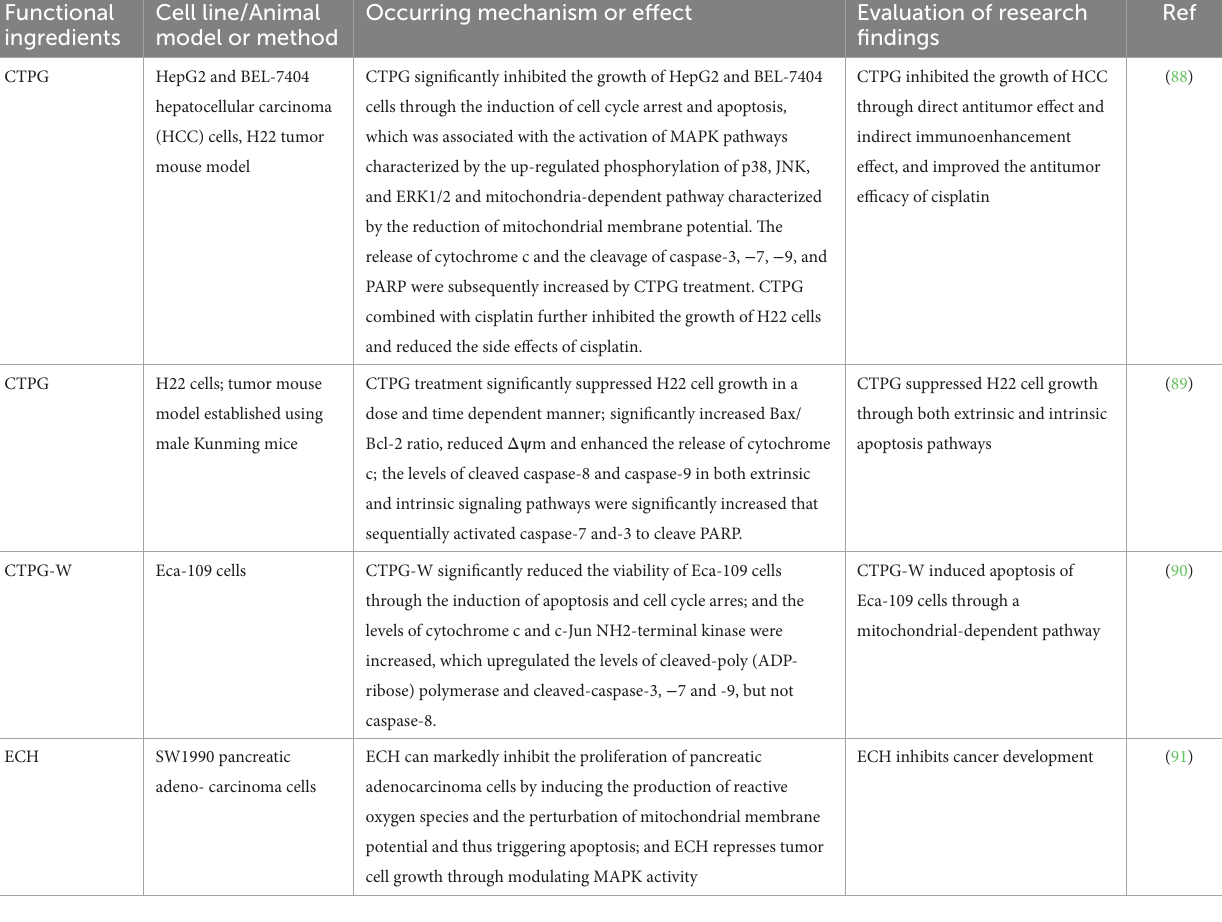
TABLE 10 Antitumor effect mechanism of cistanche. Functional ingredients